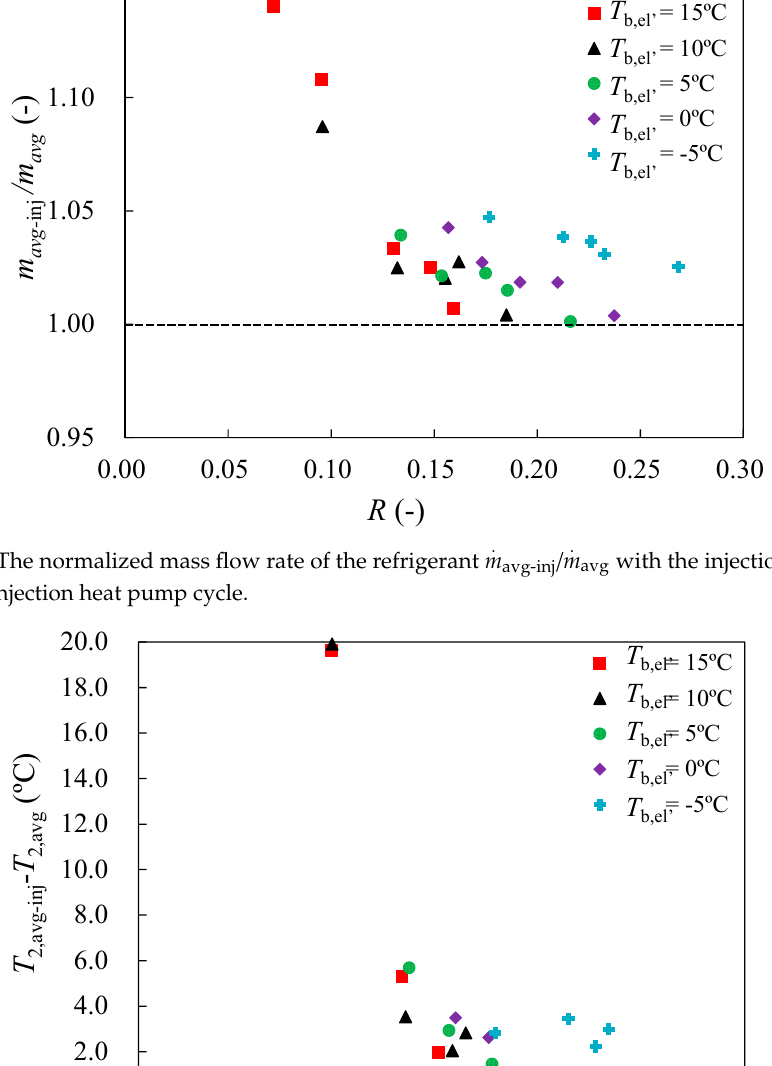
Figure 17. The effect of vapor injection on the compressor discharge temperature in the vapor injection heat pump cycle.